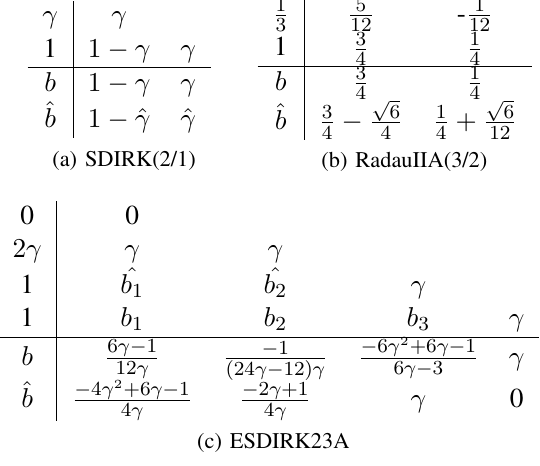
Fig. 2: Butcher tables for the three implicit Runge- Kutta methods evaluated in this paper. In Fig. 2a, √ √ 2 γ = 1 − 2 , and in Fig. 2c, γ = and ˆ γ = 2 − 5 2 4 0 . 4358665215 . In each Butcher table, ˆ b specifies the lower-order trial step solution